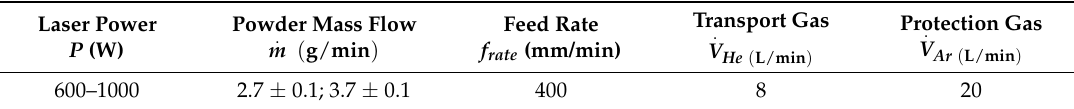
Table 2. Sets of process parameters used for single weld track experiments and the manufacturing of volumetric